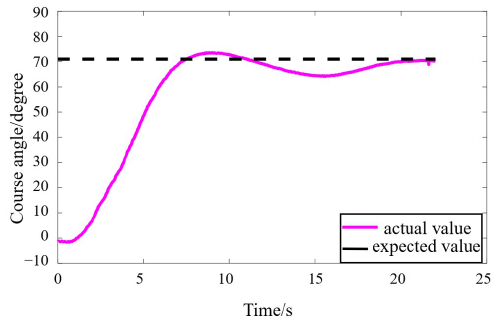
Figure 10. Results of the linear motion experiment of a single robot.